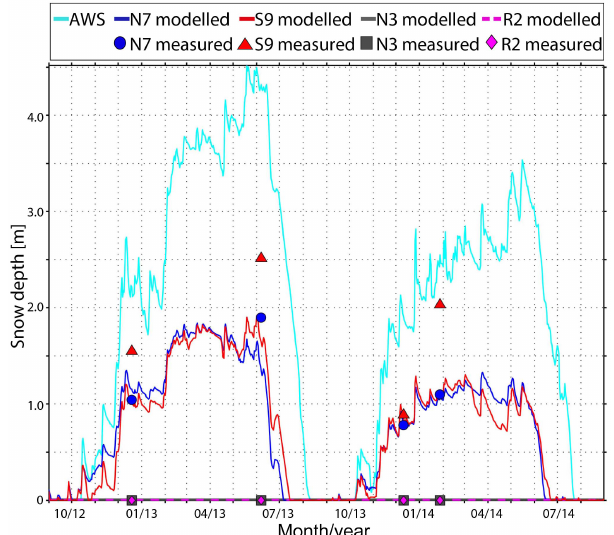
Figure 5. Snow depth evolution (lines) measured at the flat field AWS Gemsstock (AWS), as well as modelled at the NSRT loca- tions discussed in detail (N7, S9, N3, R2). Snow depths at the NSRT locations obtained by TLS are shown as blue, red, grey and pink markers. The locations N3 and R2 lack snow for the entire investi- gation period. Data from the TLS campaign on 19 December 2012 are also shown here, although the measured snow depth was used for precipitation